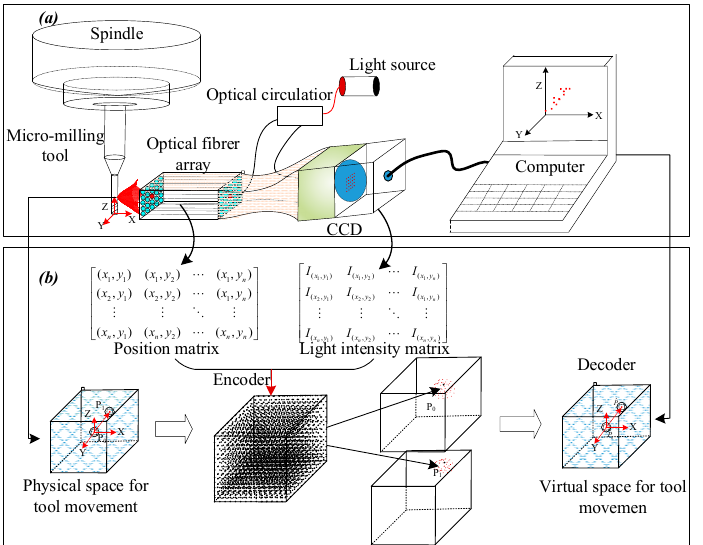
Figure 1. Principle of micro-milling tool vibration measurements. ( a ) Composition of tool vibration measurement system. ( b ) Principle of the measurement system.